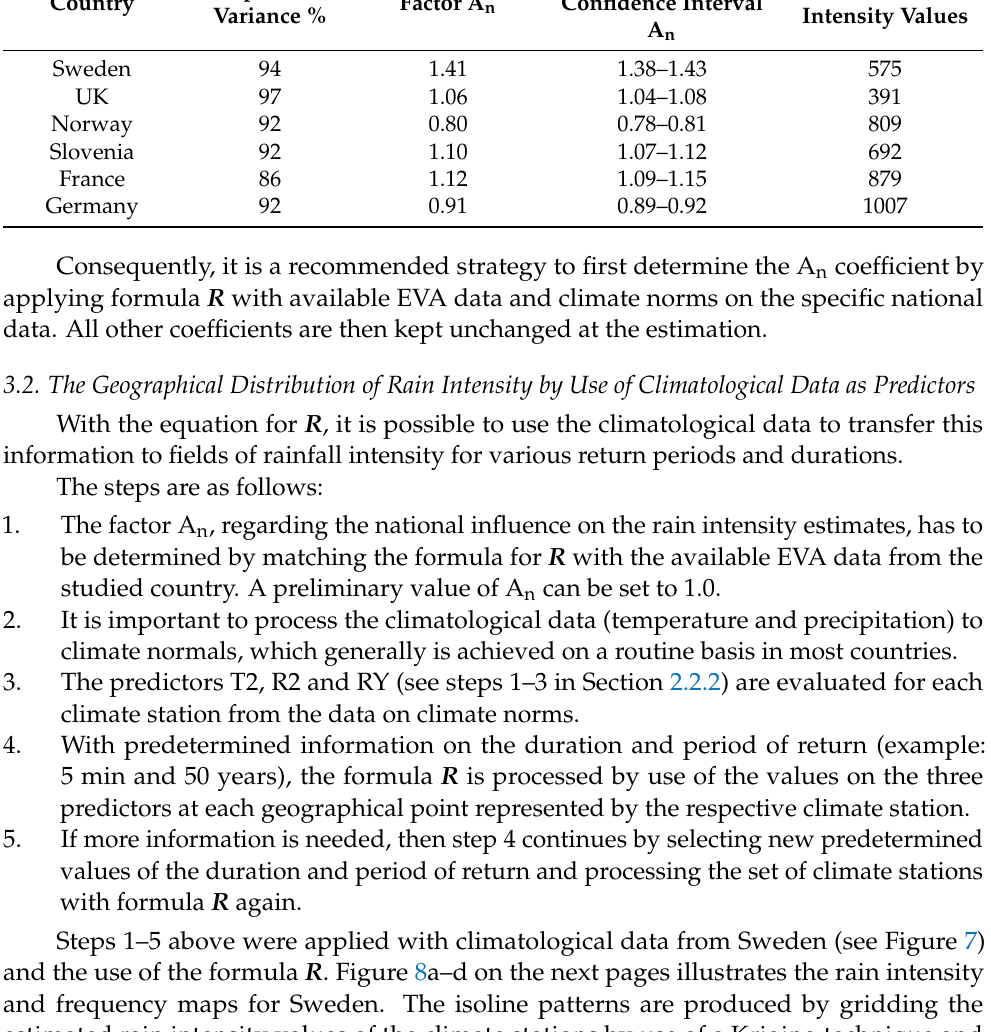
Table 4. Examples of the application of formula for R in some European s countries. See also Figure 6. Wald 95% Number of Explained Factor A n Confidence Interval Country Intensity Variance % A n